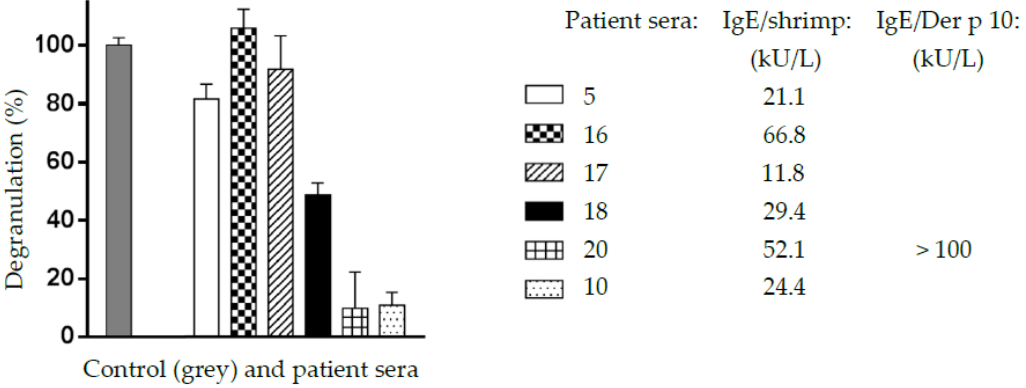
Figure 9. Degranulation potency, expressed as degranulation percentage (%), caused by the mealworm protein extract, using six di ff erent sera (5,16,17,18,20,10) from shrimp-allergic patients as IgE-binding cross-reacting allergens toward the mealworm allergenic proteins. A shrimp protein extract (grey histogram) was used as the 100% degranulation value (control C). Each value is the mean of six separate measurements. Values for specific IgE in sera 5, 16, 17, 18, 20, and 10, are